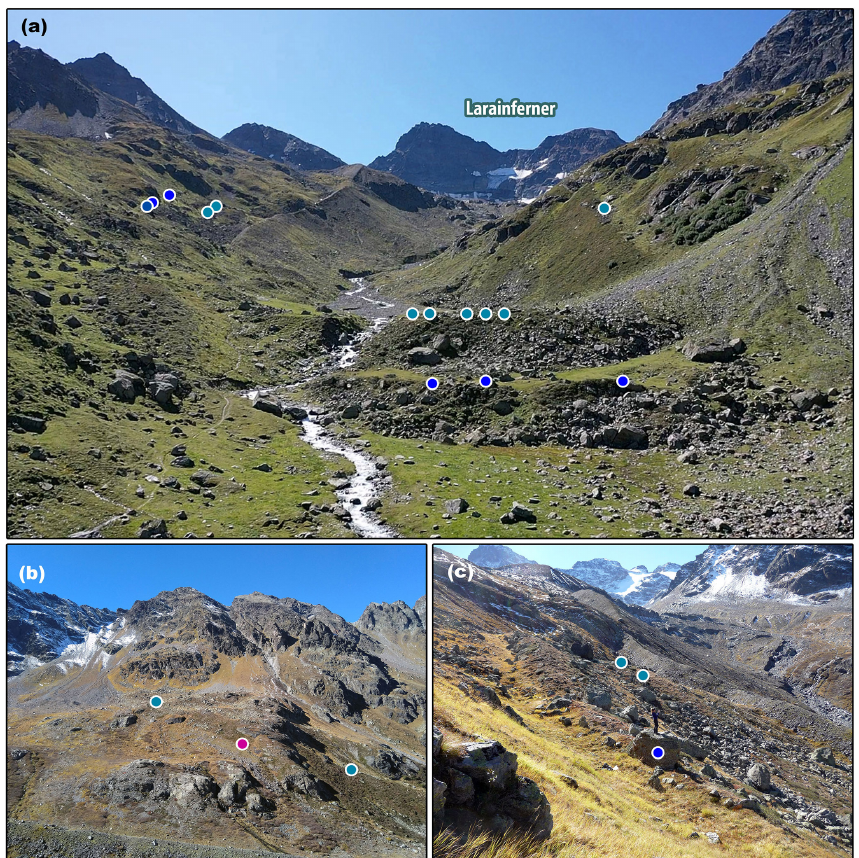
Figure 5. Photographs of Laraintal. (a) Terminal moraine section with sample locations marked with circles. (b) Left lateral valley flank with LAR-19-22 (cyan), LAR-19-23 (pink), and LAR-19-22 (cyan) from left to right. (c) Right lateral moraine set with LAR-19-15 in blue in the foreground and LAR-19-13 and LAR-19-14 in the background (cyan). For the broader context of the individual sites, see Fig.